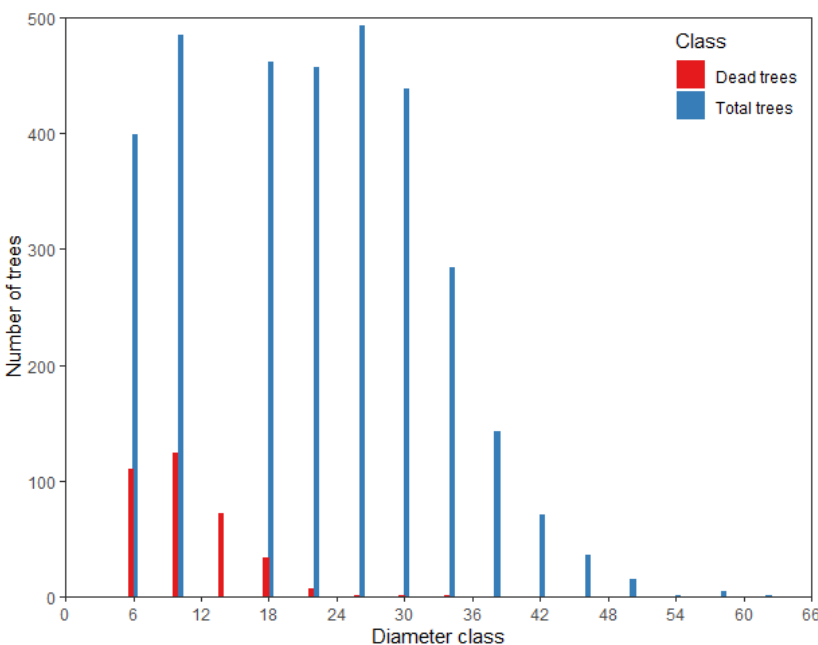
Figure 2. Distribution pattern of forest mortality.